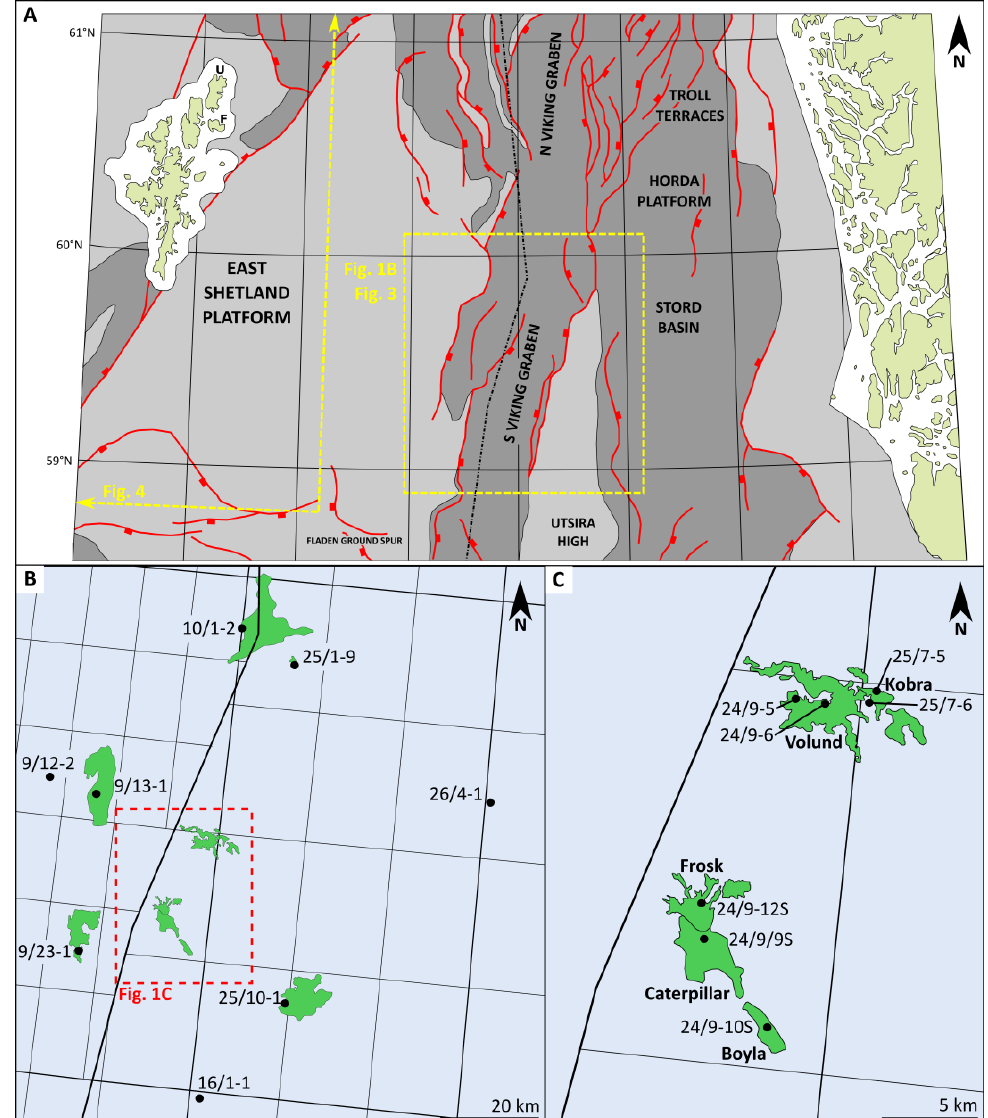
Figure 1. ( A ) Map shows the location of the study area relative to present-day shorelines, major basins and other geological features. Maps ( B ) and ( C ) show sampled wells and relevant fields, with discovery names shown in bold. Map ( C ) covers the Greater Alvheim area, the main focus of this paper.